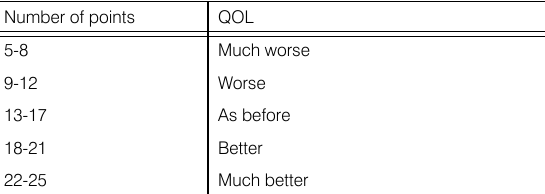
Table 1 . Evaluation of Quality of